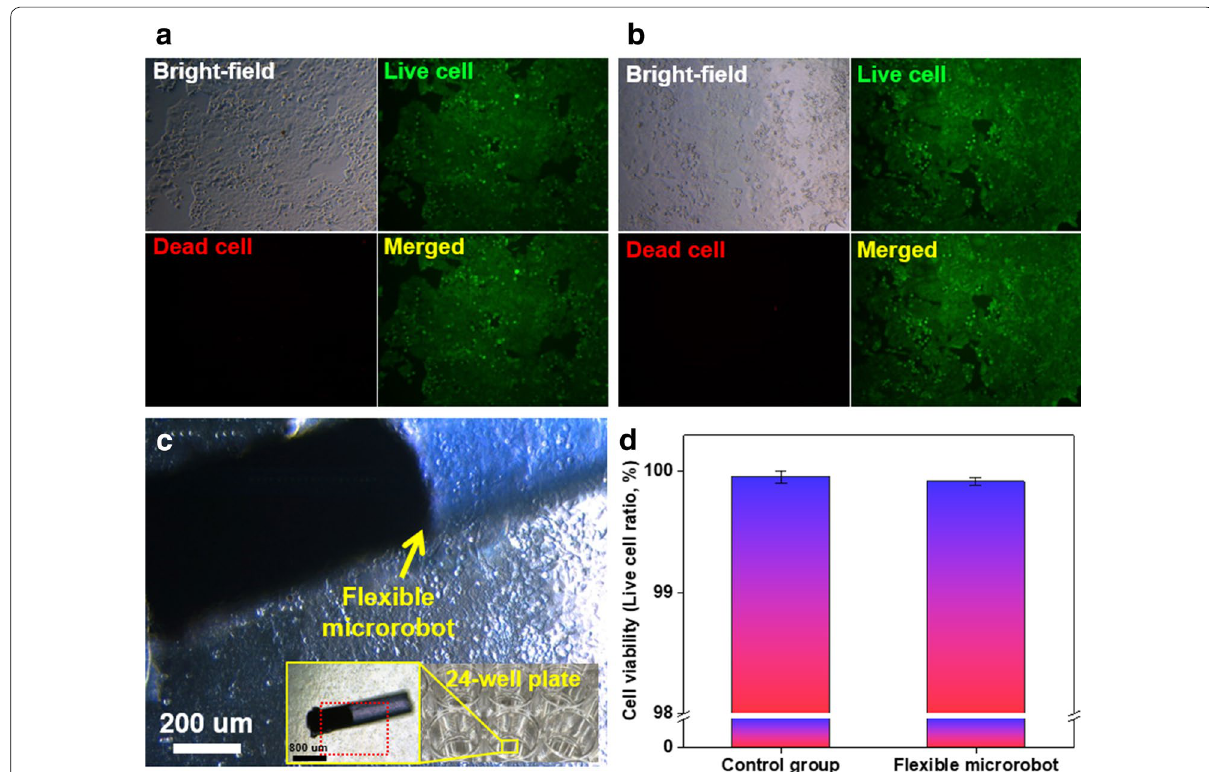
Fig. 10 The biocompatibility test results. Bright‑field and fluorescent images of HCT116 cells in wells a without flexible microrobots (control group) and b with flexible microrobots. c HCT116 cells around flexible microrobots. d Cell